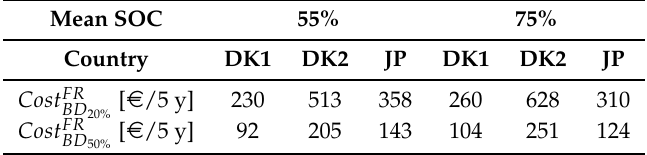
Table 5. Cost FR for 5 years period of battery usage considering the used capacity equal to 20%, 50%. BD